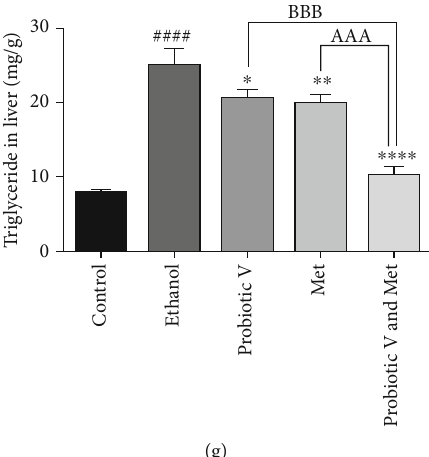
Figure 7: E ff ect of probiotic V and Met alone or in combination on ethanol-induced liver injury. Serum levels of liver enzymes, i.e., (a) ALT, (b) AST, (c) ALP, and lipid markers, i.e., (d) serum cholesterol, (e) serum triglycerides, (f) hepatic cholesterol, and (g) hepatic triglycerides, were determined using a microplate reader. Values are expressed as mean ± SD of six rats. Statistical signi fi cance was assessed by one-way ANOVA followed by Tukey post hoc test. Statistical analysis: ### p < 0 : 001 and #### p < 0.0001 compared with control group; ∗ p < 0 : 05 , ∗∗ p < 0 : 01 , and ∗∗∗∗ p < 0 : 0001 compared with ethanol group; A,B p < 0 : 05 , AA,BB p < 0 : 01 , and AAA,BBB p < 0 : 001 compared with probiotic V and Met combinatorial group. ALT: alanine aminotransferase; AST: aspartate aminotransferase; ALP: alkaline